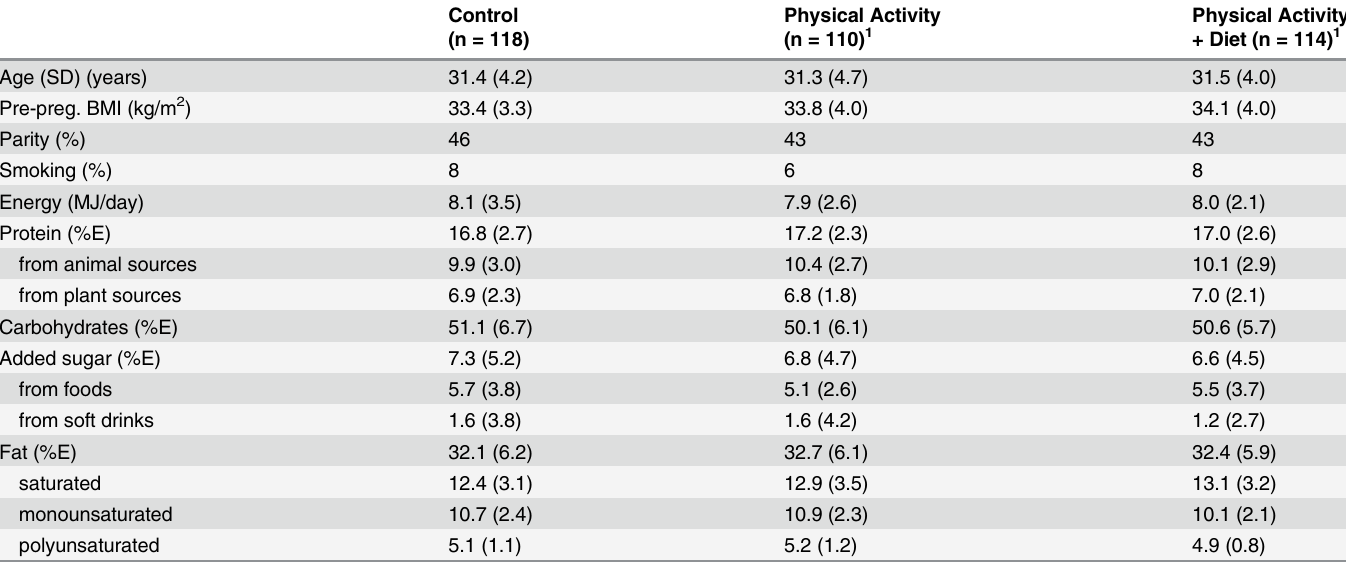
Table 1. Maternal characteristics and dietary intakes of selected macronutrients at baseline among participants reporting their diet at baseline (wk 11 – 14) and endpoint (wk 36 – 37) in the TOP-Study (n =